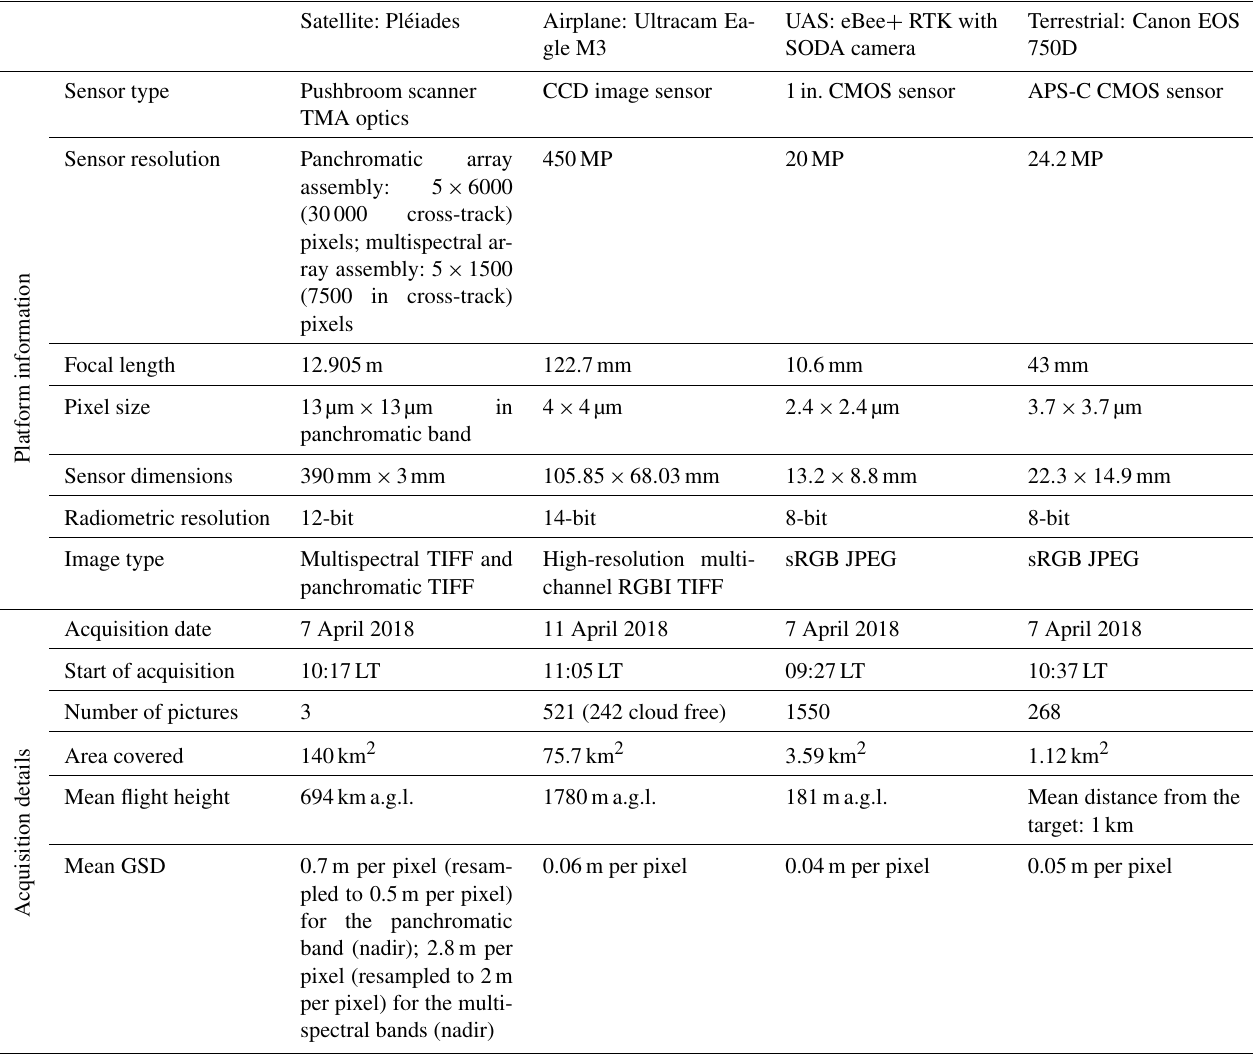
Table 1. Summary of the photographic data collection with the satellite, airplane, UAS and terrestrial platforms. Satellite: Pléiades Airplane: Ultracam Ea- UAS: eBee + RTK with Terrestrial: Canon EOS gle M3 SODA camera